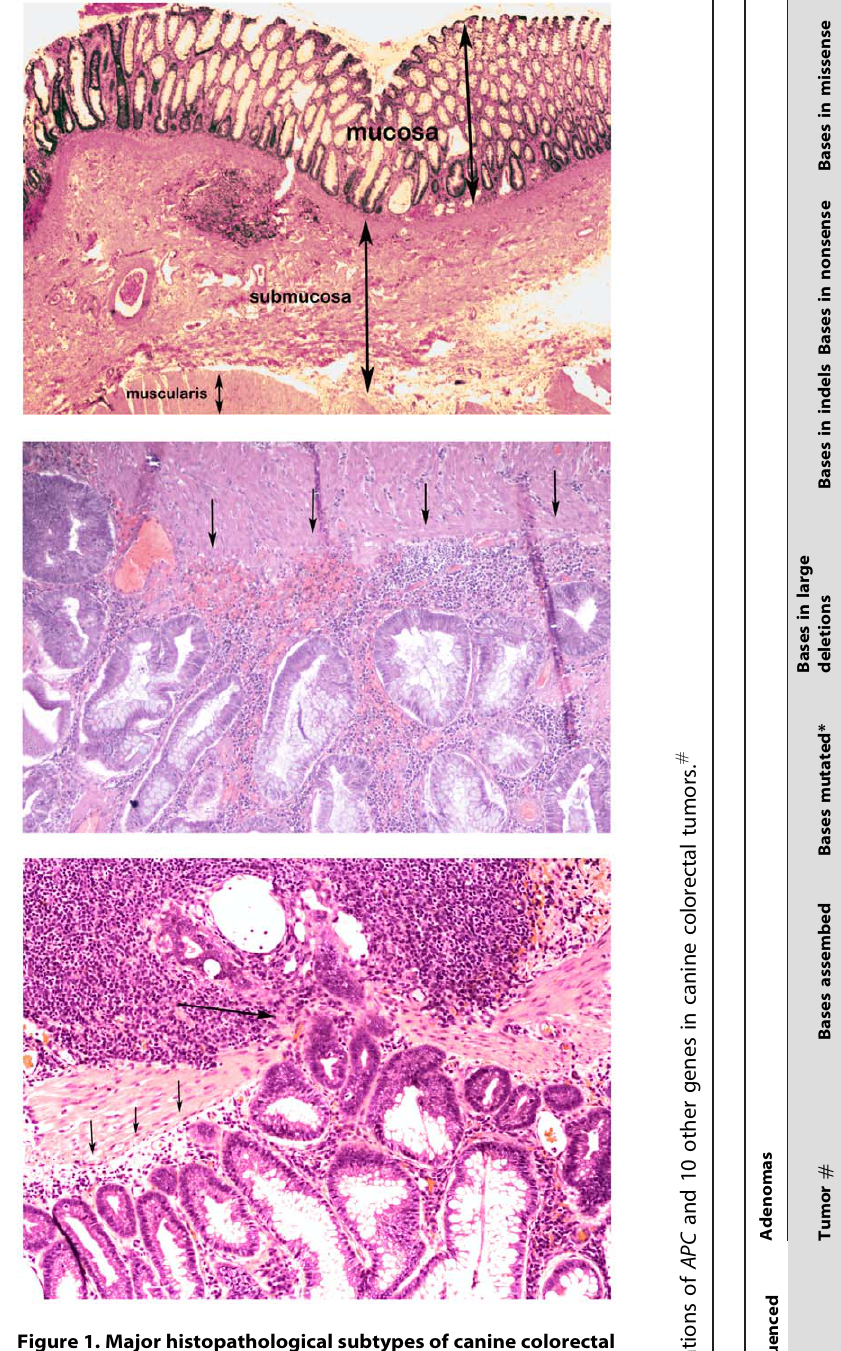
Figure 1. Major histopathological subtypes of canine colorectal tumors investigated. Shown from top to bottom are H&E staining images for normal colon (mucosa, submucosa, and muscle layers as indicated), colorectal adenoma, and colorectal adenocarcinoma. In the adenoma (middle), there is preservation of a distinct basement membrane (arrows). In the adenocarcinoma (bottom), a section of the basement membrane (small arrows) has been disrupted and penetrated through by neoplastic cells invading the submucosa (large arrow).